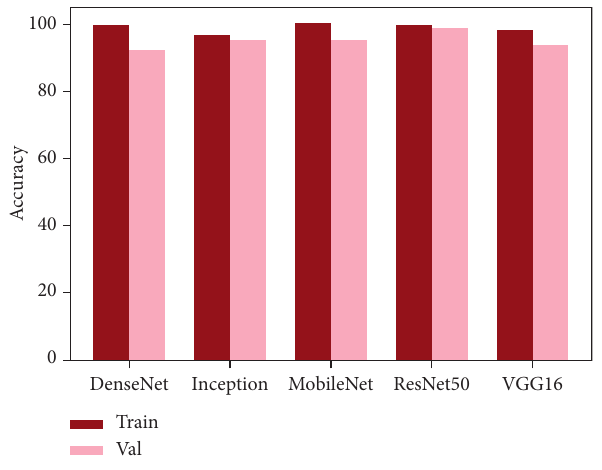
Figure 6: Results of the pretrained classifiers. Table 2: Classification results on transfer learning models. Model